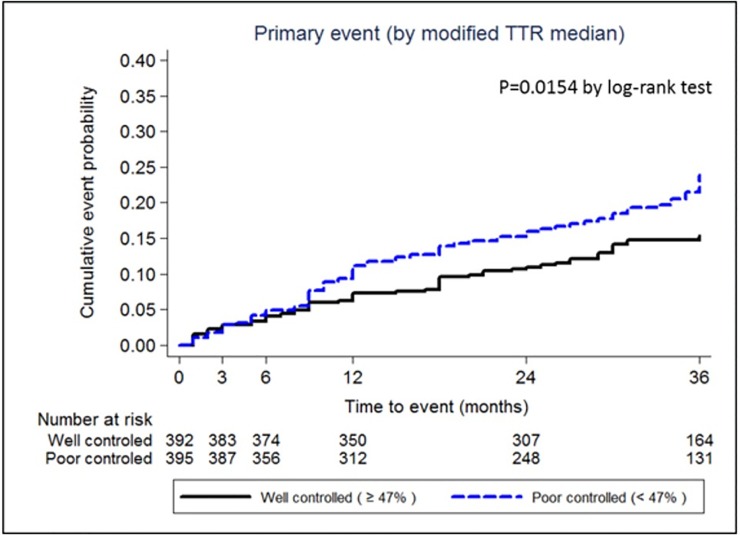
Cumulative incidence curve for clinical events.